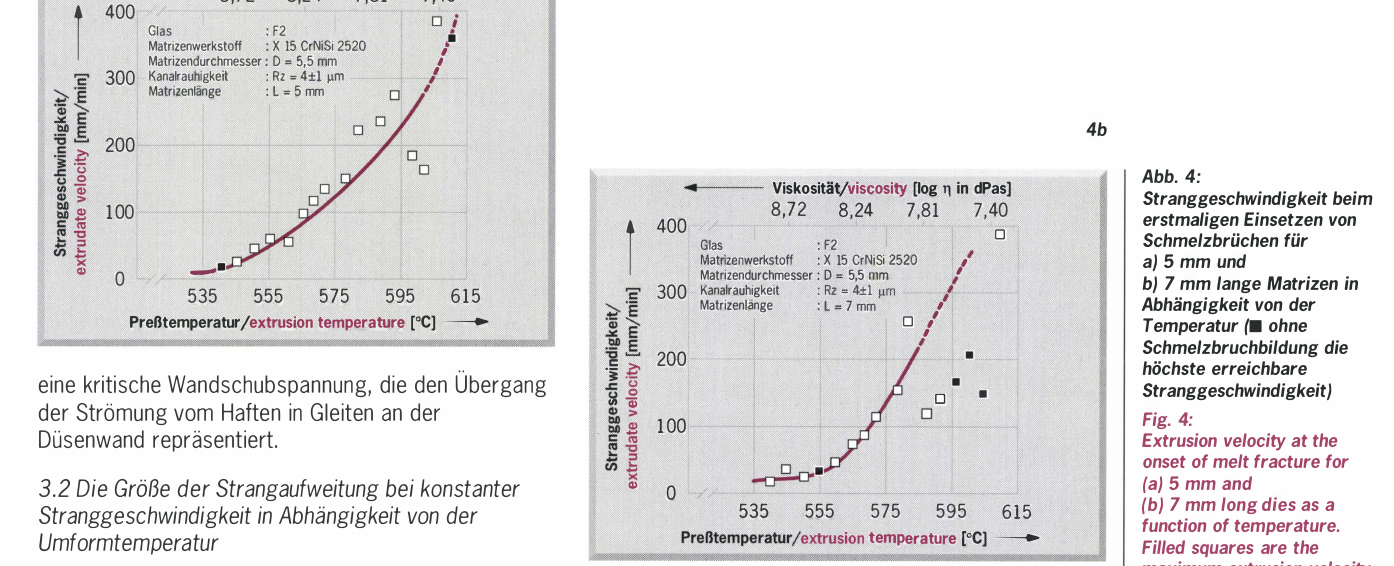
Fig. 4: Extrusion velocity at the onset of melt fracture for (a) 5 mm and (b) 7 mm long dies as a function of temperature. Filled squares are the maximum extrusion velocity attained without the occurrence of melt